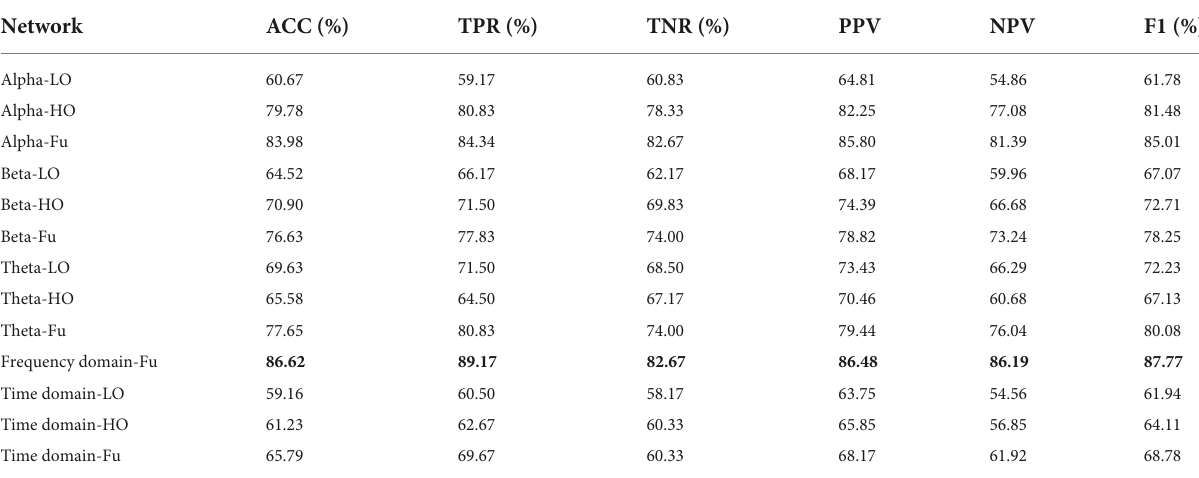
TABLE 2 MDD classification using different